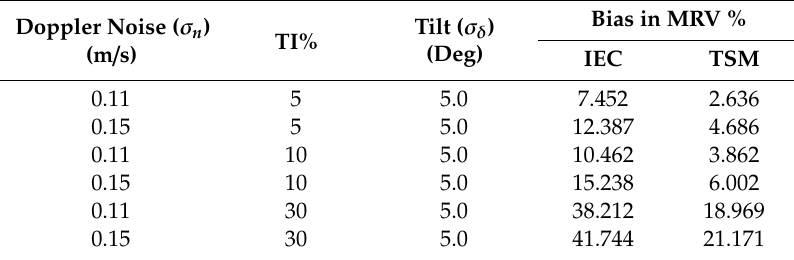
Table 7. Real world examples of uncertainty factors of MRV with Doppler noise, TI and